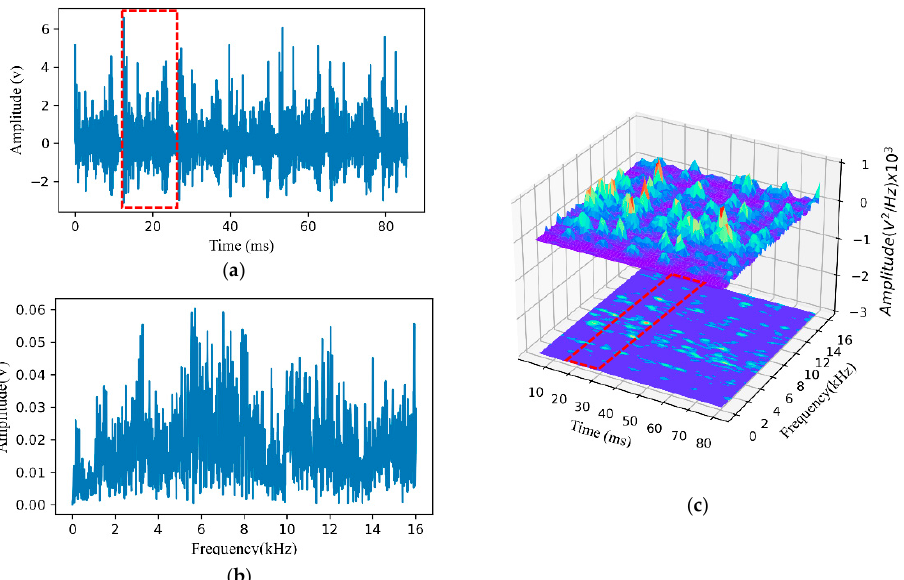
Figure 7. Time domain waveform, frequency spectrum, and time–frequency spectrum of arc sound. ( a ) Arc sound. ( b ) Frequency spectrum of arc sound. ( c ) Time-frequency spectrum of arc sound.